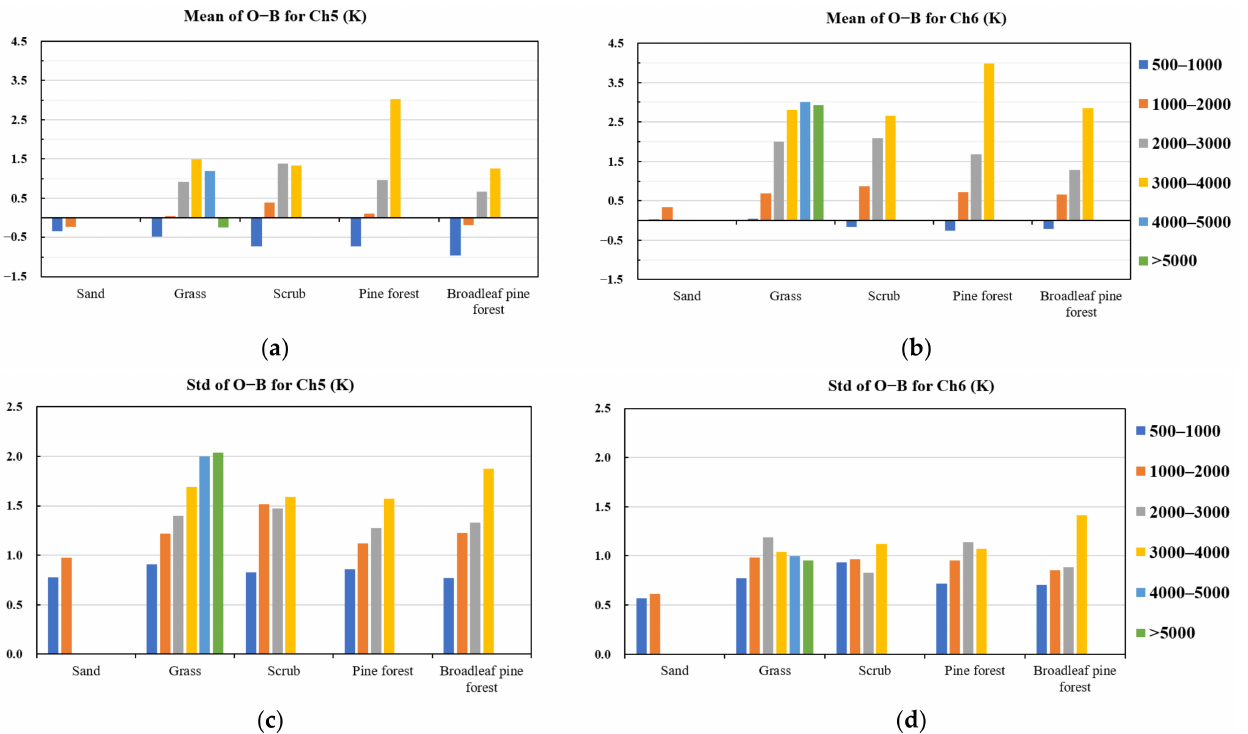
Figure 9. Histograms of ( a , b ) the average O − B and ( c , d ) standard deviation of clear-sky observations for AMSU-A ( a , c ) channels 5 and ( b , d ) channel 6 for five vegetation types at different topographic heights over the Tibetan Plateau region on 1–31 August